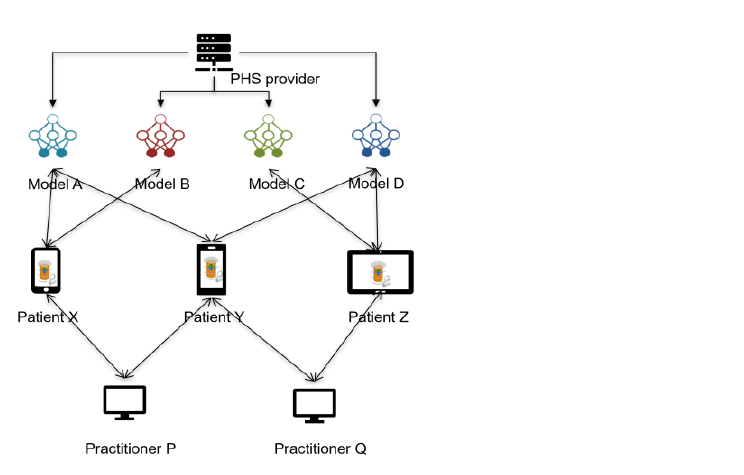
Figure 2. PHS provider offers multiple personalized health care models (tracking of pain, opioid disorder, etc.) to patients on their P2P PHS client software. Every patient could subscribe to any relevant models, and each model depends on several heterogeneous features (or data)—represented with different colors—from other patients and other sources for the training.